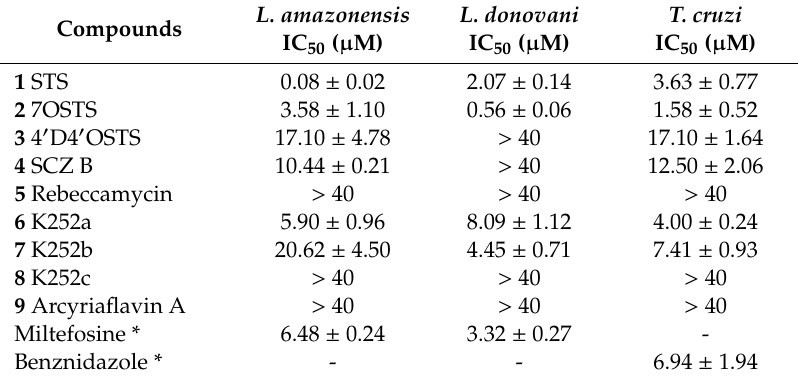
Table 1. Antikinetoplastid activity of ICZ metabolites isolated from Streptomyces sanyensis ( 1 - 4 ) and concentrations (Mean concentration ±